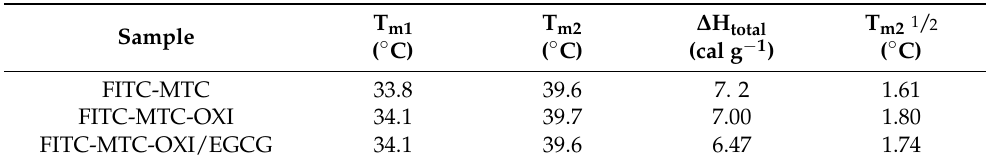
Table 1. Detailed thermodynamic parameters: transition temperature (T m ), total calorimetric enthalpy ( ∆ H total), and transition half-widths (T m 1 / 2 ) obtained from DSC profiles of FITC-MTC, FITC-MTC- OXI, and